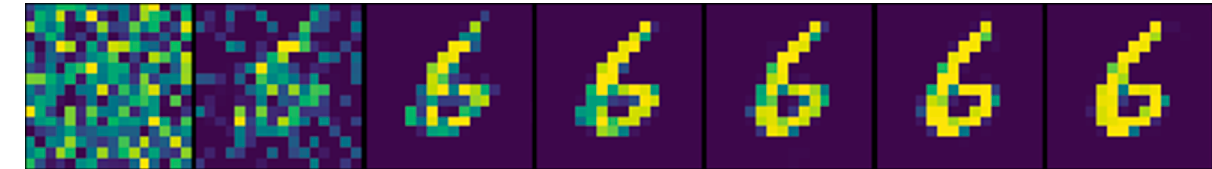
Figure 6. Weight map after training; each image is for a feature layer neuron.